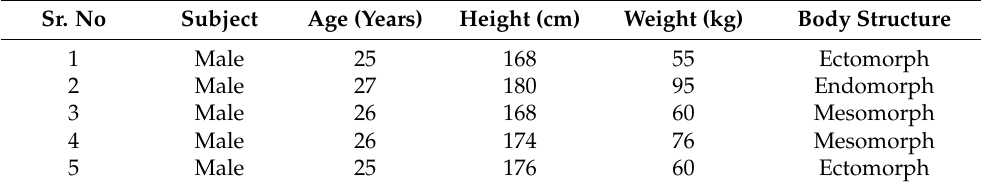
Table 3. Subject participation in